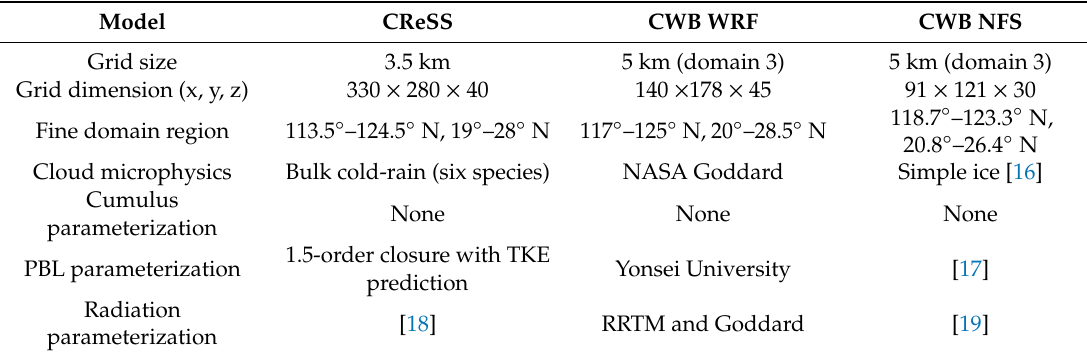
Table 1. Fine-domain configuration and the major physical packages used in the CReSS (version 2.2), CWB WRF (version 2.2.1), and CWB NFS